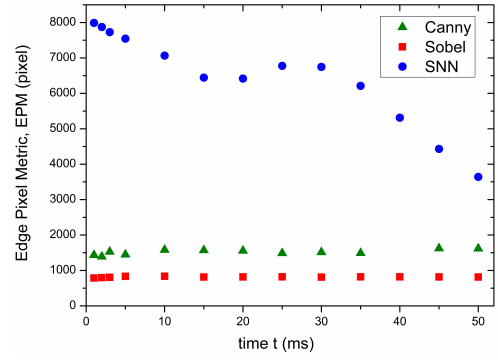
Figure 6. Total number of edge pixels in the SNN edge map of the input image as a function of simulated exposure time